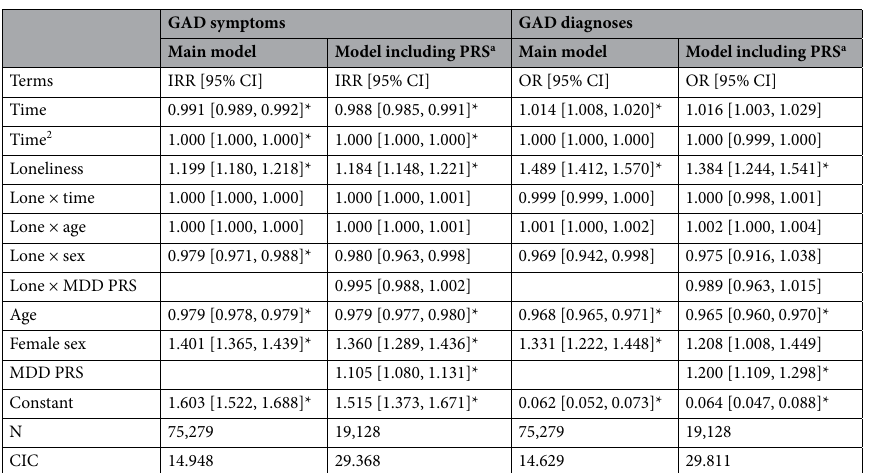
Table 3. Table of GEE models for outcome of GAD symptoms and diagnoses. Displayed are incidence rate ratios (IRR) and odds ratios (OR) with 95% confidence intervals for the different terms in the GEE models. Asterisks indicate statistical significance at Bonferroni-corrected α = 0.00125. All models include a linear and squared time term, a main loneliness effect and a loneliness-time interaction. Furthermore, terms for age and female sex are included both as main effect and a loneliness interaction term. The models in genotyped samples also include an MDD polygenic risk score both as main effect and as a loneliness interaction. N refers to the number of individuals included in the dataset. The correlated information criterion (CIC) is a measure of fit for GEE models. a In sample with genotype data available. Models include the first 10 principle components of the genotype data as covariates as well (not